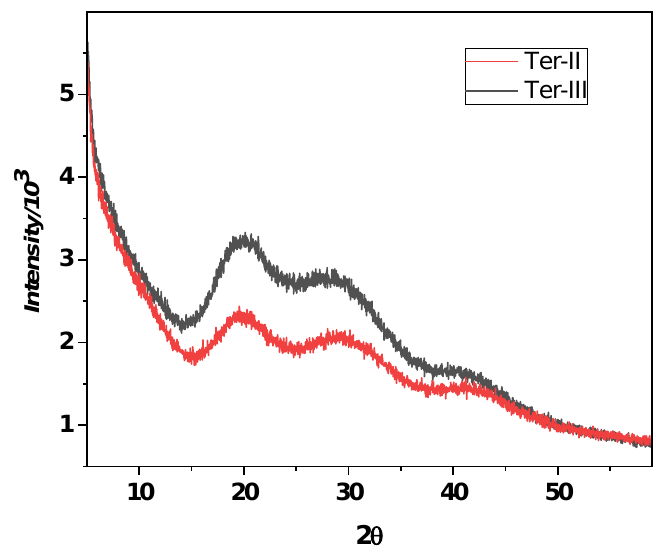
Figure 3. XRD patterns for the Ter-II and Ter-III samples.